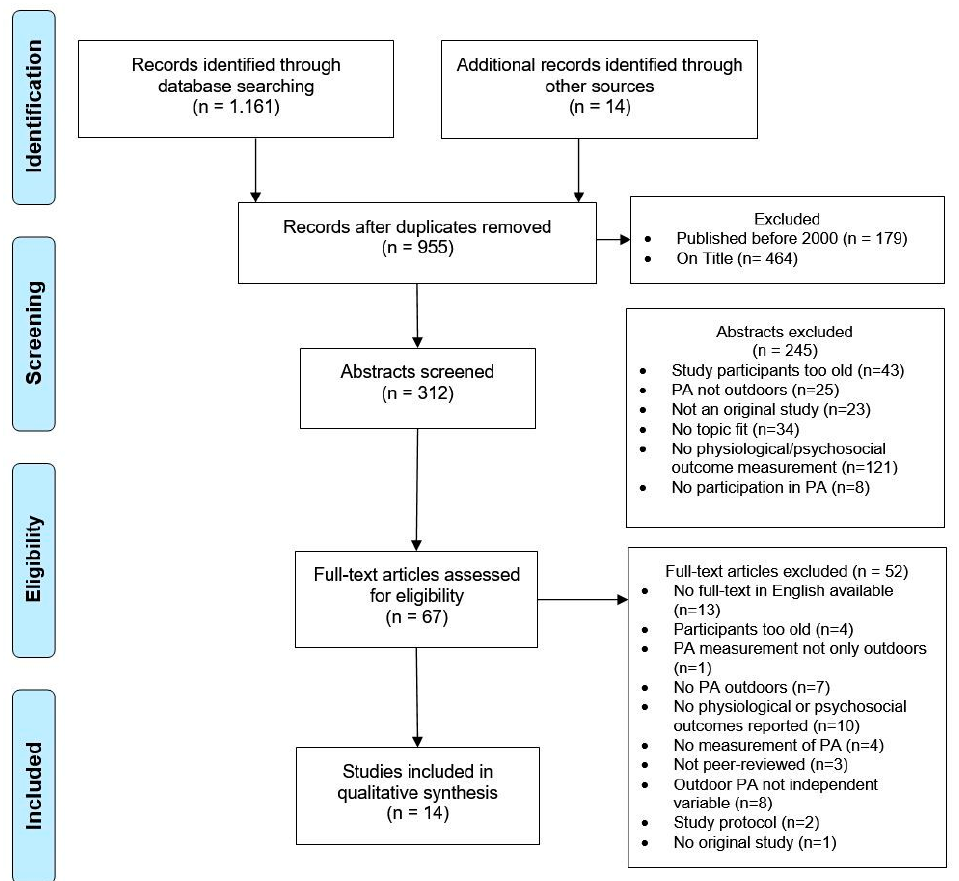
Figure 1. Flow diagram of the study selection process.